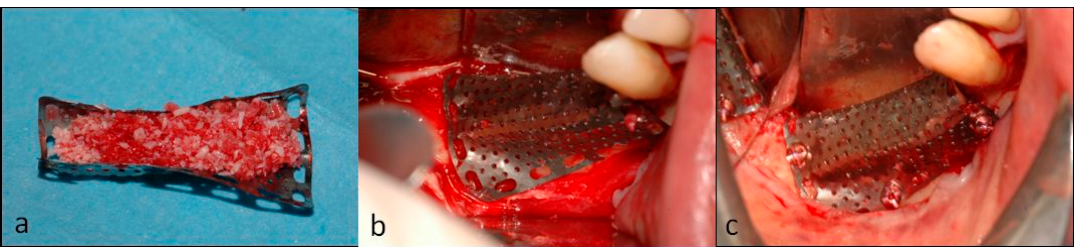
defect. ( c ) The mesh was fixed with mini-screws.